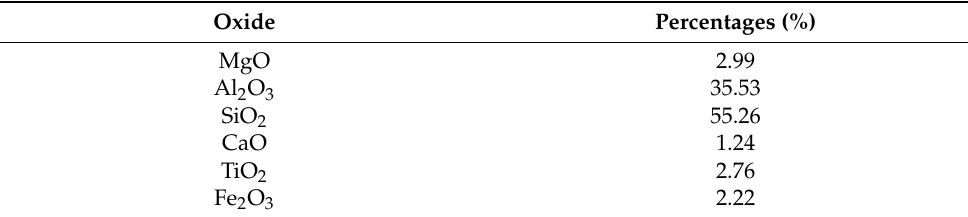
Figure 1. EDX analysis of kaolin clay. Table 2. The percentages of compositional oxides in kaolin clay.